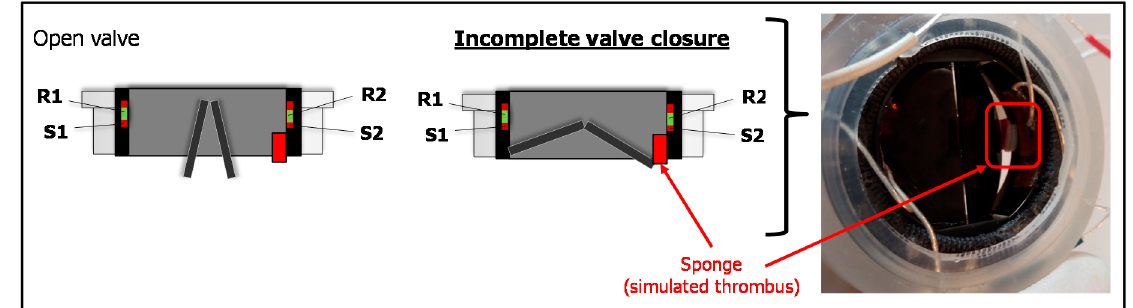
Figure 4. The experimentally reproduced alteration of valve leaflet dynamics: Incomplete valve closure due to the obstacle caused by the sponge simulating a thrombus formation.